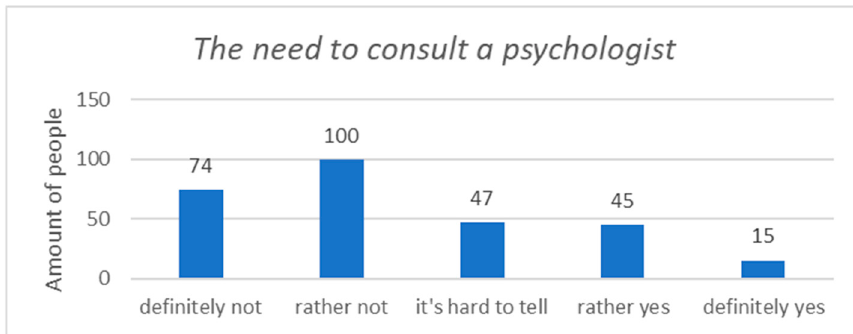
Figure 4. The need to consult a psychologist in connection with the work performed.